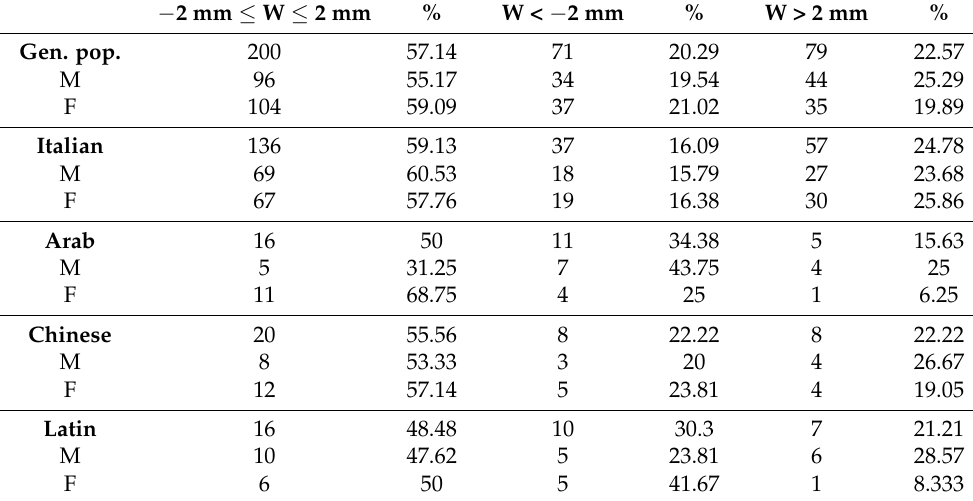
Table 8. Distribution of the Wits Index values in the selected patient sample.